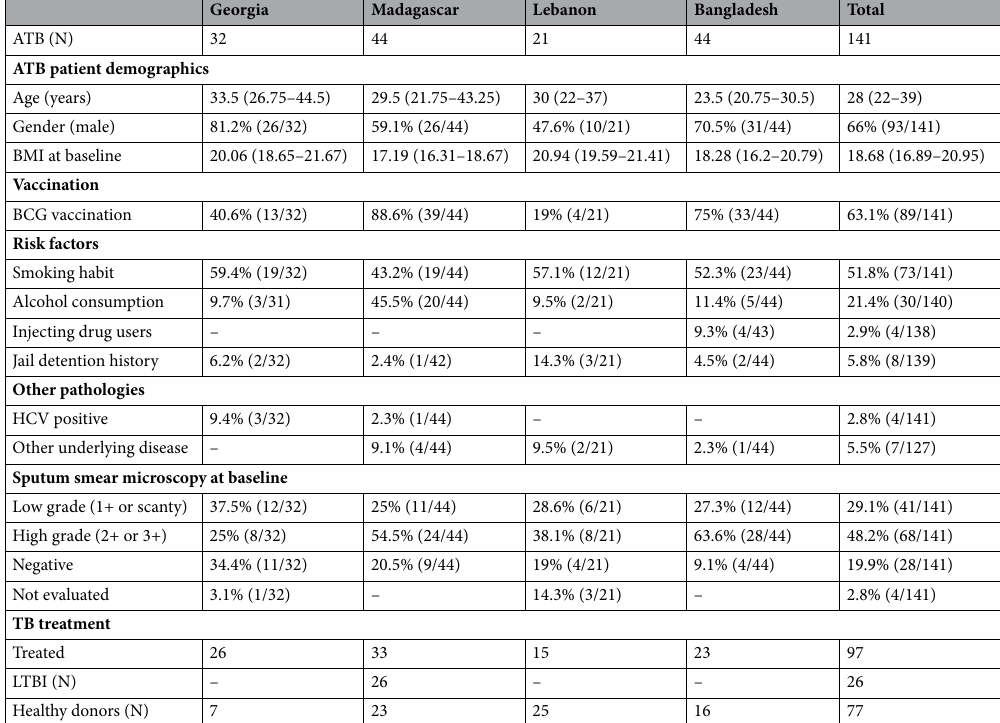
Table 1. Baseline sociodemographic and clinical characteristics of ATB patients in the four cohorts. TB Tuberculosis, BMI Body Mass Index, LTBI latent TB infection, IQR interquartile range. Data were given as % (N) or median